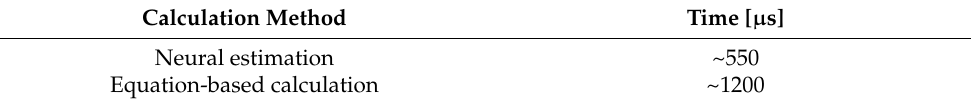
Figure 5. Results of neural distance estimator: ( a ) comparison of estimator response and nominal distance; ( b ) relative error value. Table 1. Comparison of computing times for different methods of distance calculation.